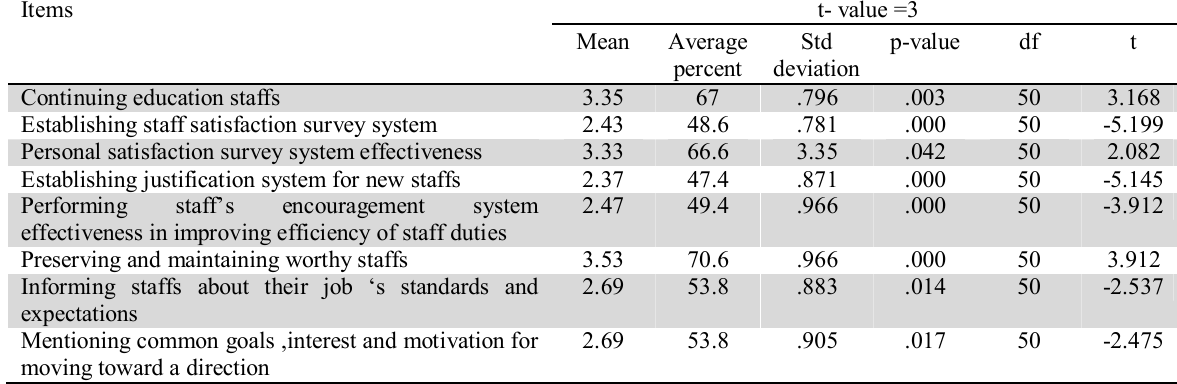
Staff management- T-Test